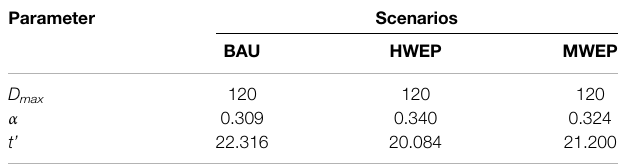
TABLE 4 | Wind power diffusion model parameters. Parameter